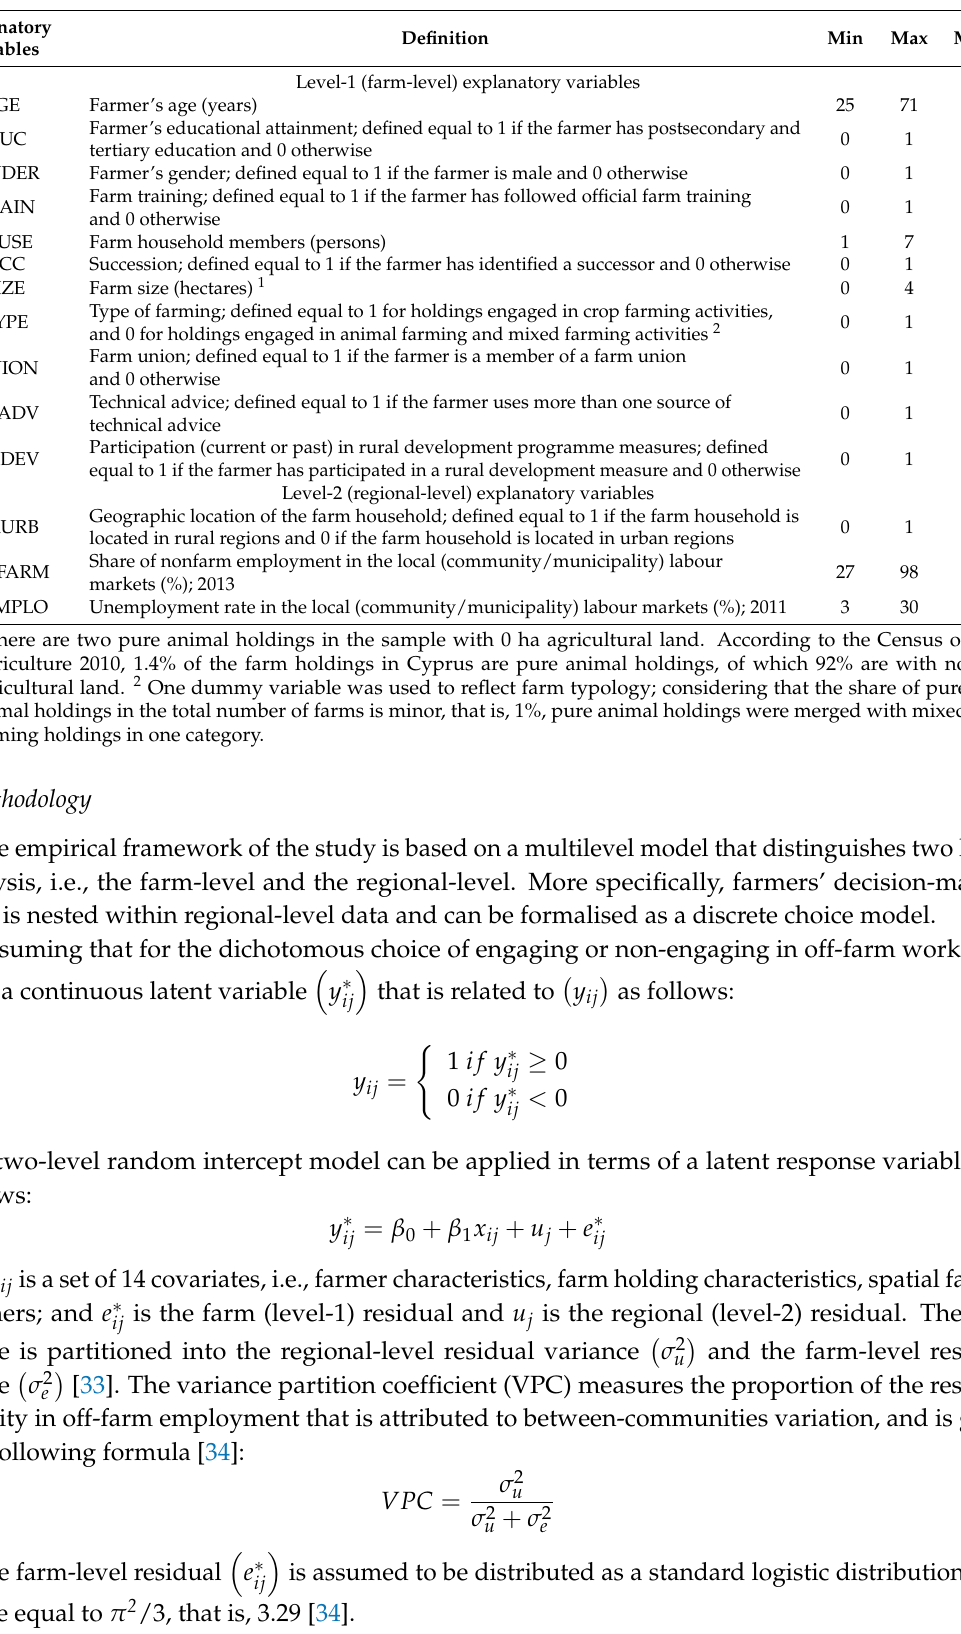
Table 2. Description of the explanatory variables used in the multilevel logistic regression model and key summary statistics for the 193 surveyed farmers in